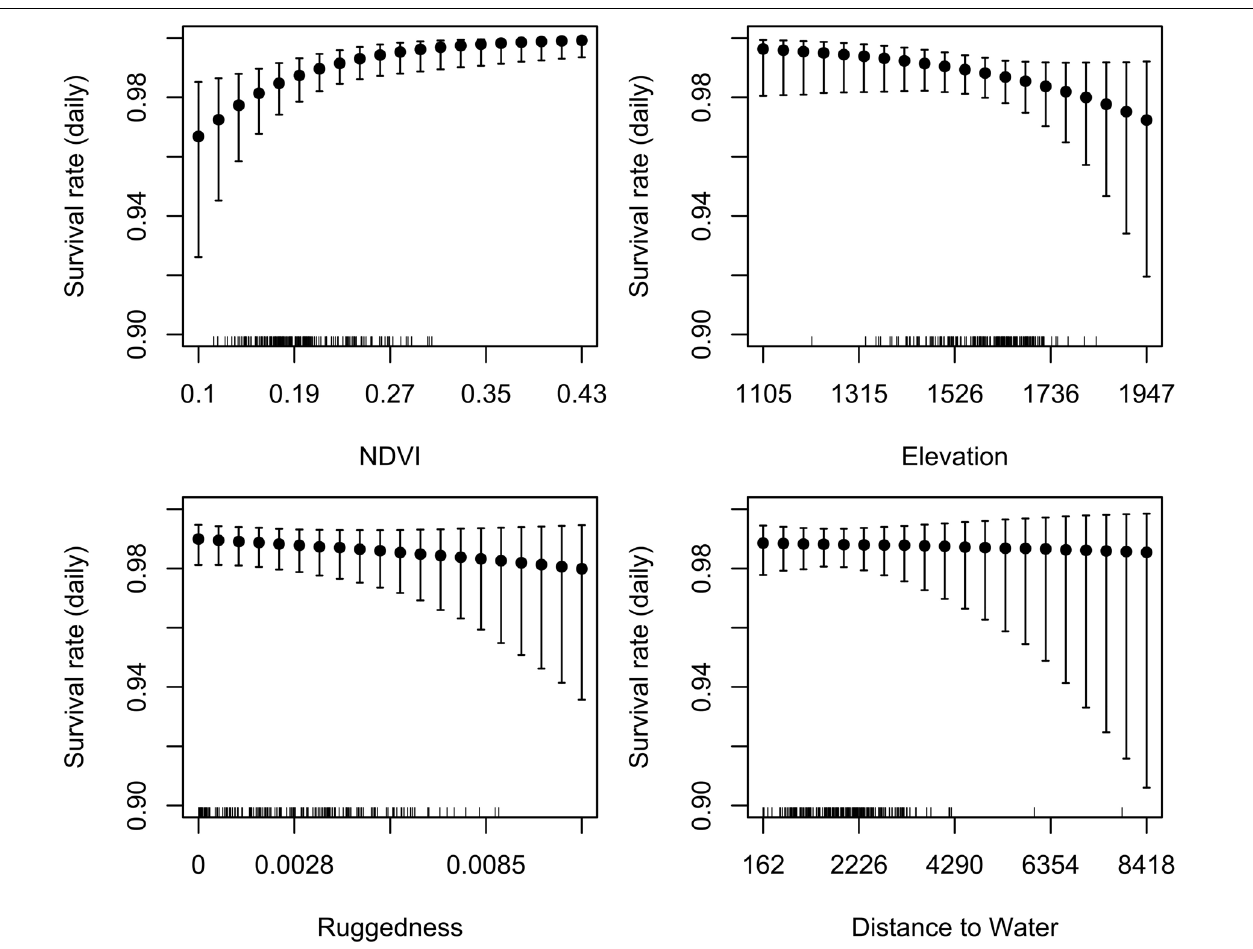
FIGURE 6 | Partial dependence plots illustrating the relationship between daily offspring survival rate and corresponding mean environmental attributes (extracted from 30 m rasters) of habitats used by maternal female mule deer while provisioning young ( n = 67 fitted with GPS collars) on the Mojave National Preserve (2013–2016), determined on the basis of a Bayesian known-fate survival analysis. Models were fit using data from up to 120 days post-parturition; after 120 days offspring were considered to be successfully recruited. There was strong evidence for a positive effect of NDVI on offspring survival, weak evidence for a negative effect of elevation, and little to no evidence for effects of terrain ruggedness or distance to